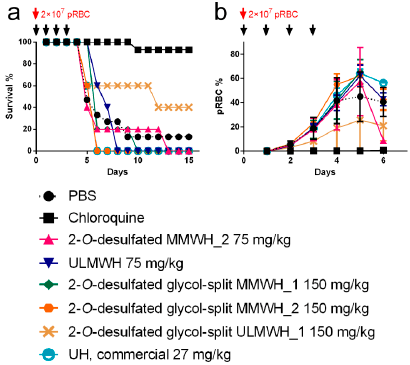
Figure 6. Antimalarial activity in vivo of heparin-derived structures. Mice survival curves ( a ) and parasitemia percentage ( b ) following treatment with the tested compounds at the concentrations indicated. The black arrows indicate the times of test sample administration. n = 5 in each group, except PBS- ( n = 15) and chloroquine-treated mice ( n = 14).